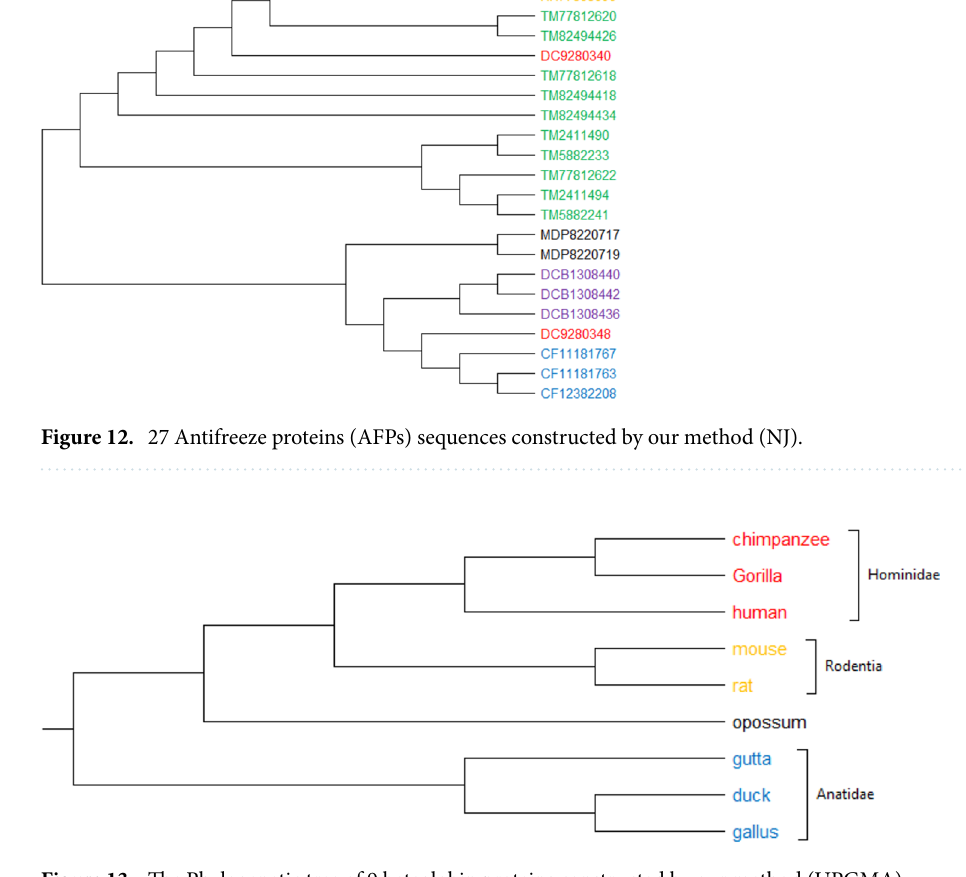
Figure 13. The Phylogenetic tree of 9 betaglobin proteins constructed by our method